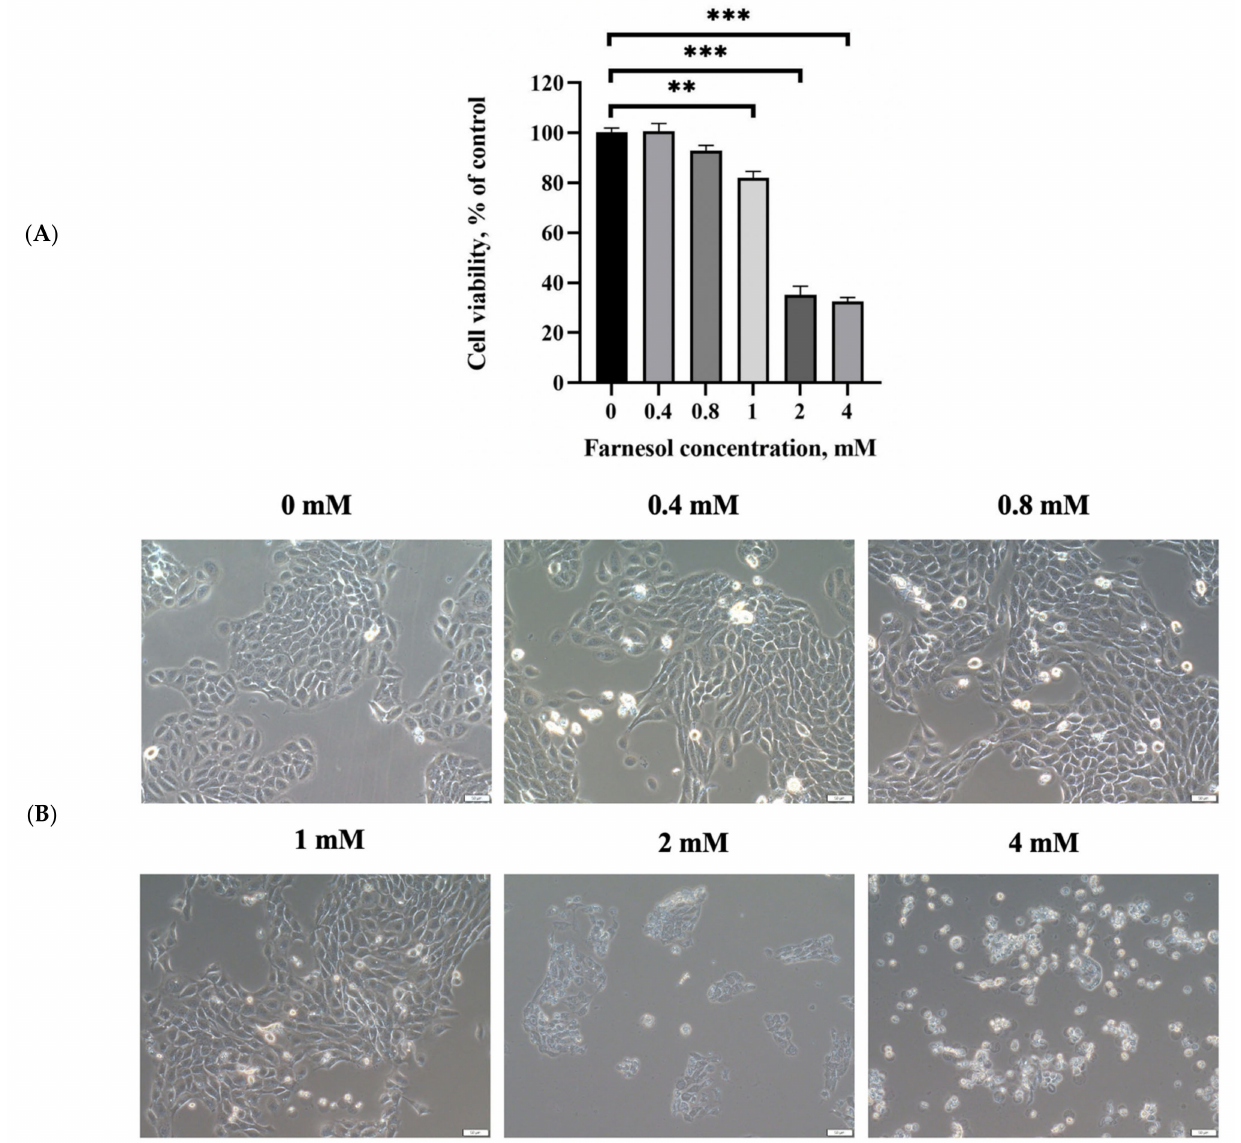
Figure 3. ( A ) Cell viability assay displaying the low cytotoxicity of farnesol on HaCaT keratinocytes. ( B ) Cell morphology images of keratinocytes after various treatments with the indicated the concentrations of farnesol, supporting the cell viability assay results (Bar, 50 µ m). ** p < 0.01; *** p < 0.001 (through